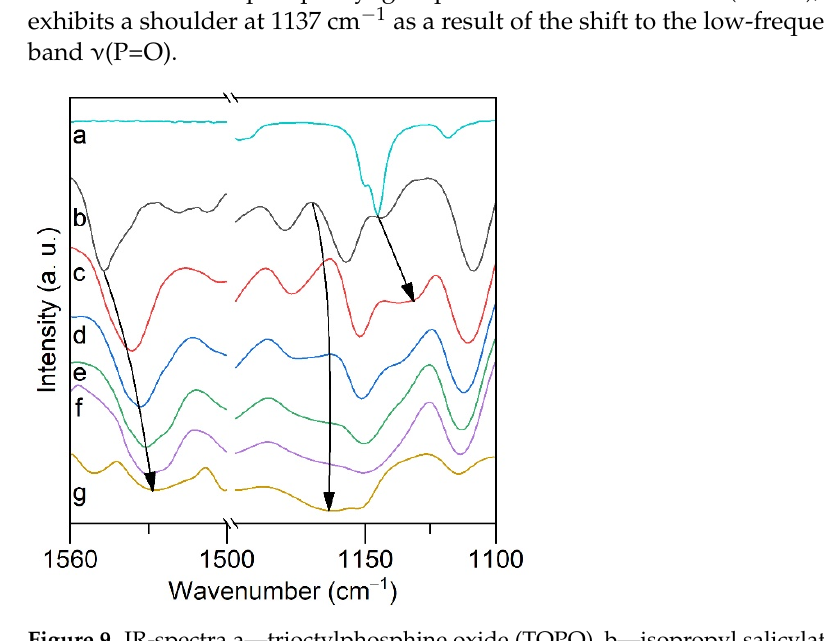
Figure 9. IR-spectra a—trioctylphosphine oxide (TOPO), b—isopropyl salicylate (HL), c—lithium extract of HL:TOPO 2:1, d—HL:TOPO 1:1, e—HL:TOPO 1:2, f—HL:TOPO 1:4, g—HL:TOPO 1:10.